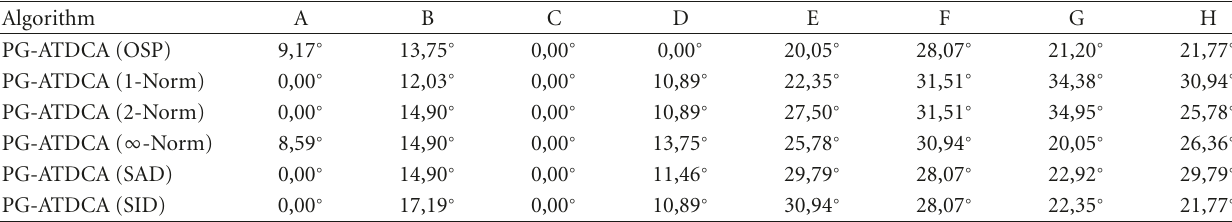
Table 3: Spectral angle values (in degrees) between target pixels and known ground targets for PG-ATDCA (implemented using RPM). The results reported for the OSP distance in PG-ATDCA are the same as those reported for the same distance in Table 2 since OSP implements the RPM strategy by